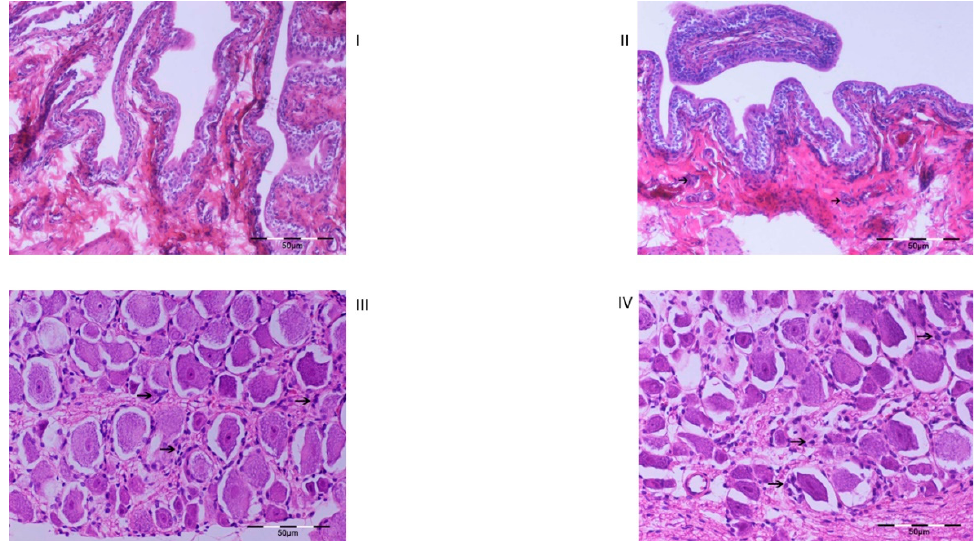
Figure 6. Images from histological examination of tissue sections of bladder and ganglia (hematoxylin and eosin staining, magnification × 200). Image I : no histopathological findings observed. Image II : mild infiltration from inflammatory cells is observed. Image III : no histopathological findings were observed. Image IV : small increase in the number of satellite cells is observed.